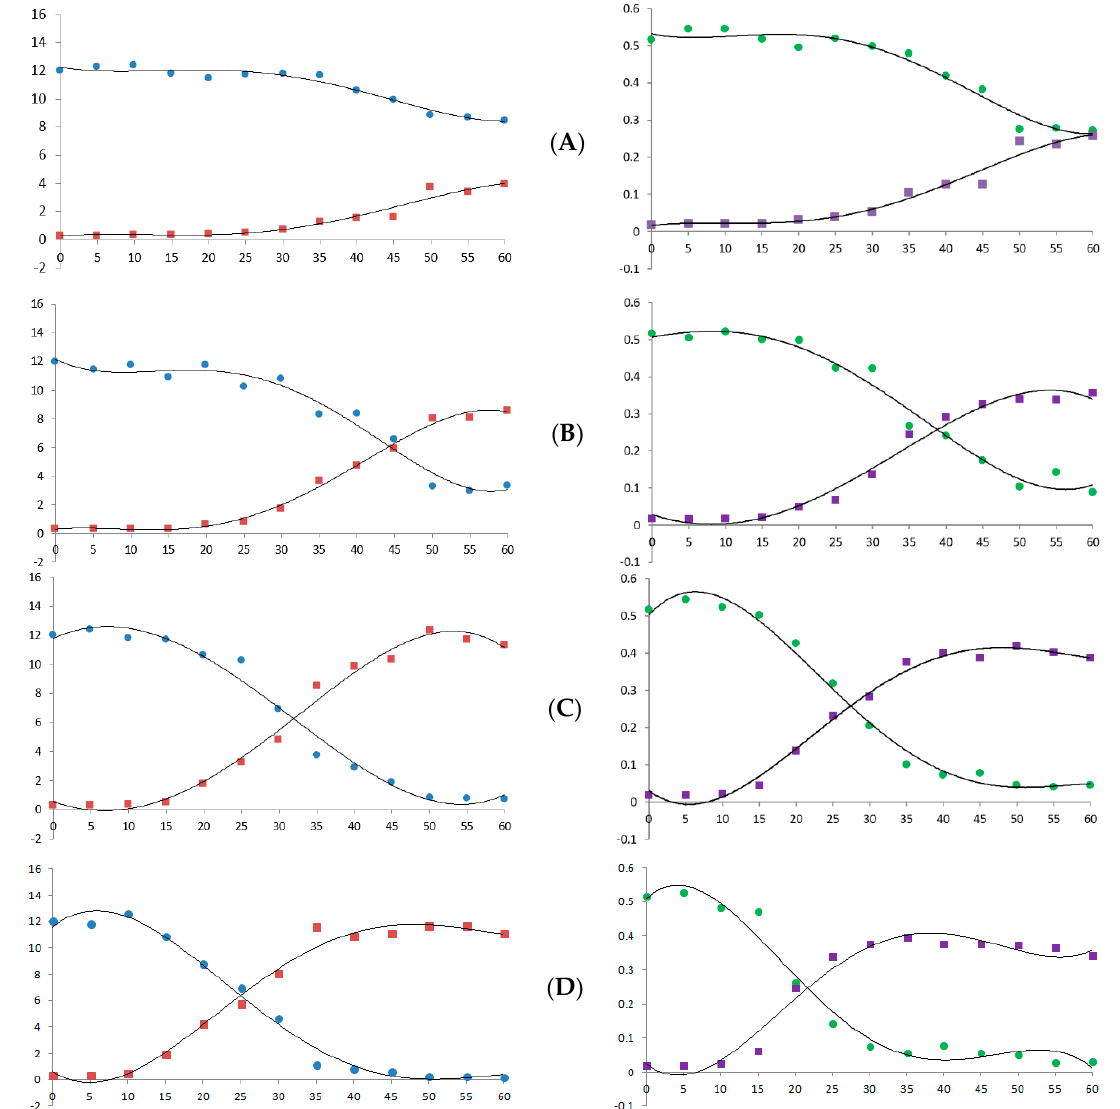
Figure 6. Decarboxylation curve of hemp flower powder with changes in temperature and time. ( A ) 90 °C; ( B ) 105 °C; ( C ) 120 °C; ( D ) 135 °C. X-axis, time (min); Y-axis, concentration ( μ g/mL, ×10,000). Blue dots, CBDA; red dots, CBD; green dots, Δ 9-THCA; purple dots, Δ 9-THC.